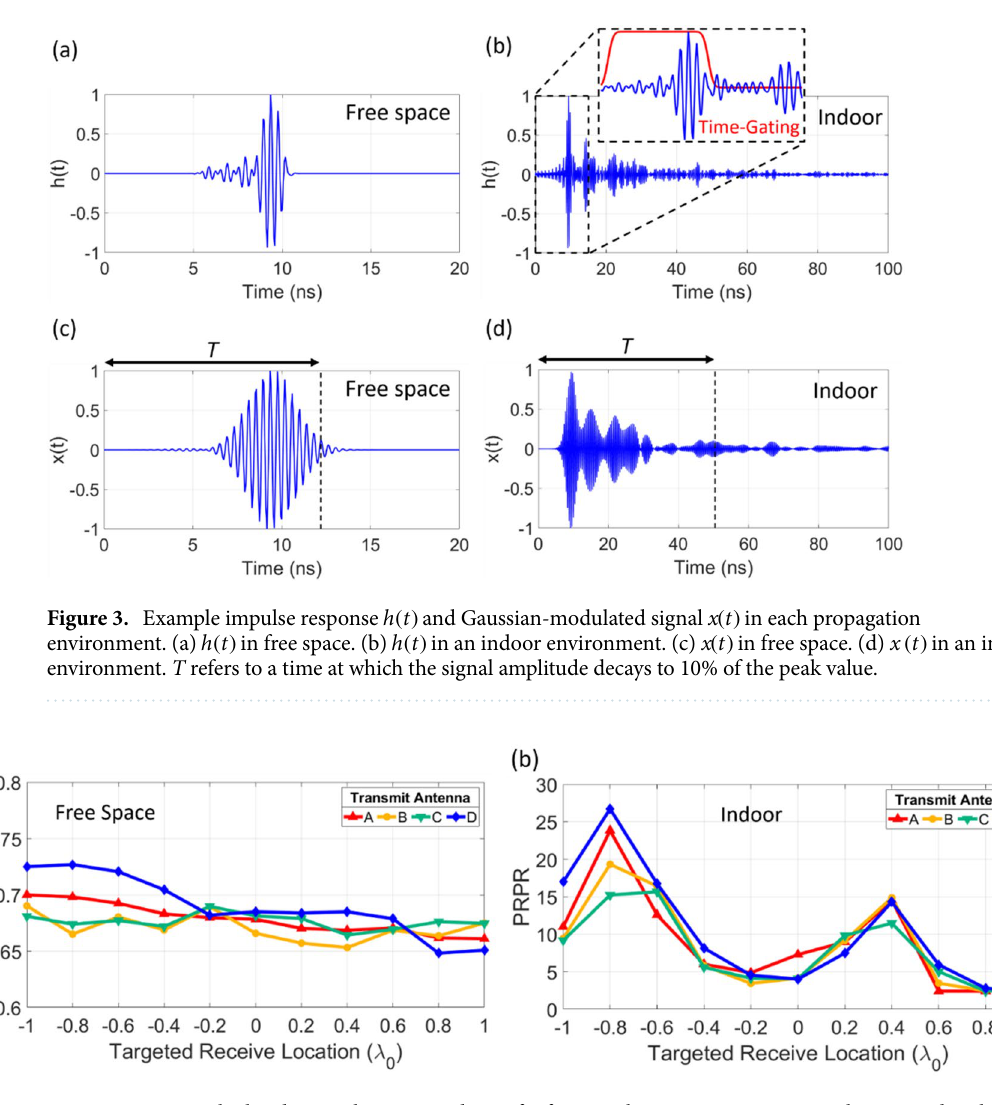
Figure 4. PRPR calculated using the measured transfer function between transmit array element and each targeted receive antenna location. ( a ) Free space, ( b ) indoor